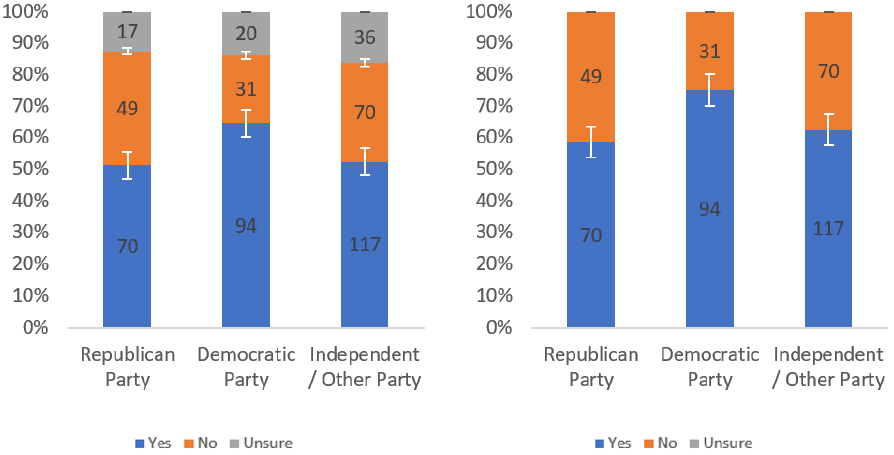
Figure A23. Responses regarding respondents’ willingness to review by party affiliation including ( left ) and excluding ( right ) unsure responses.